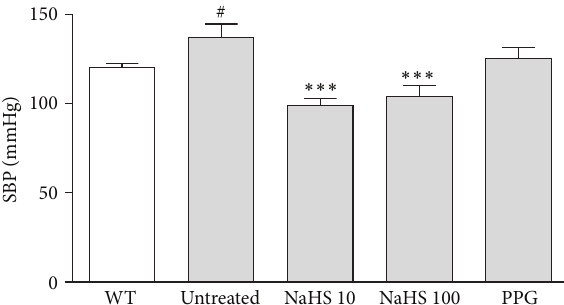
Figure 1: Systolic blood pressure (SBP) measured by the tail- cuff method in WT (open bar) and fat-fed ApoE −/− mice (shaded bar). Fat-fed ApoE −/− mice had a significantly higher SBP than age matched WT controls. SBP was significantly reduced in fat- fed ApoE −/− mice treated with either 10 or 100 𝜇 mol/kg/day NaHS. Treatment with PPG 30 mg/kg/day had no effect on SBP. # 𝑃 < 0.05 , 𝑡 -test WT versus fat-fed ApoE −/− mice, ∗∗∗ 𝑃 < 0.001 , ANOVA, untreated versus treated, 𝑛 = 6 – 9